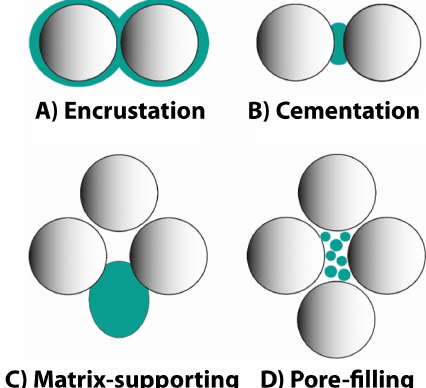
Figure 1. Various distributions of how hydrate might be located in the sedimentary matrix as discussed in previous studies: encrusta- tion, cementation, matrix supporting and pore-filling (modified after Dai et al.,